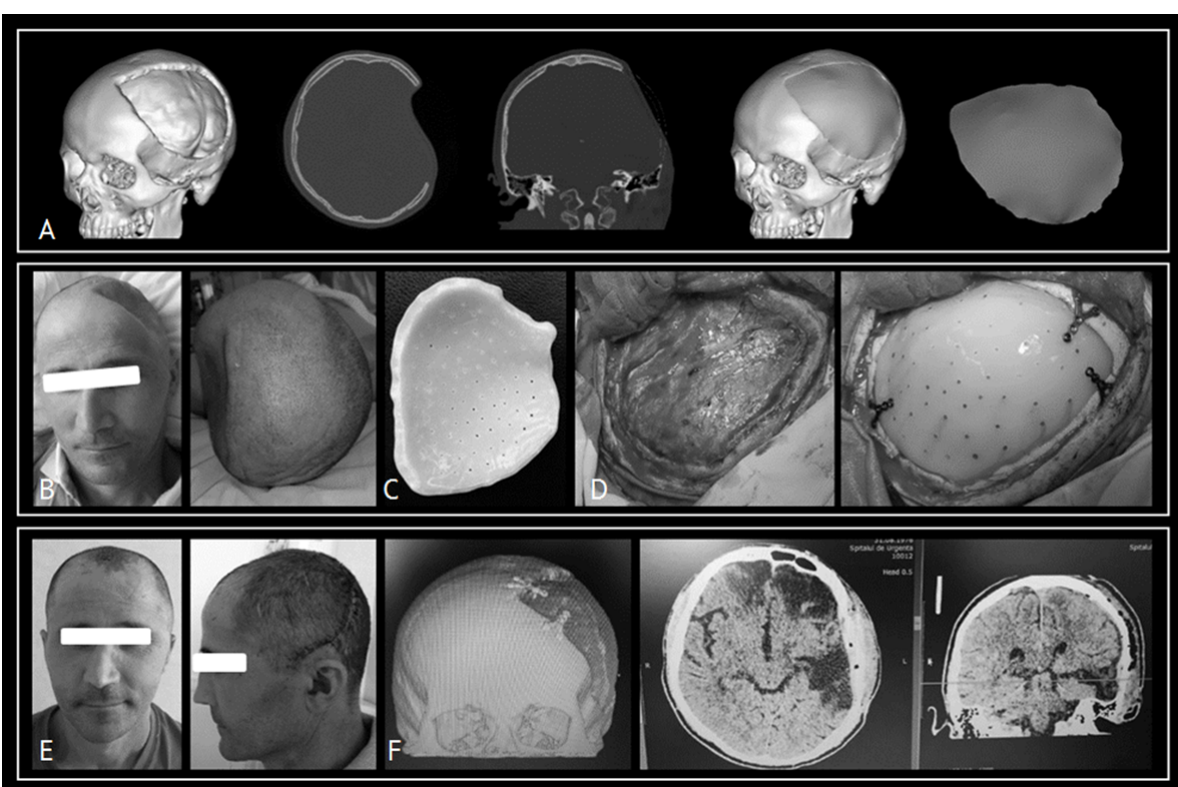
Figure 3 . Clinical case. A - preoperative virtual surgical planning and PSI modeling, B - patient with SoT, C - personalized cranial plate from PMMA, D - intraoperative aspect of cranioplasty intervention: the meningolysis stage (left) and implantation of the personalized cranial plate from PMMA (right), E - same patient after cranioplasty surgery, F- postoperative CT images with bone reconstruction.